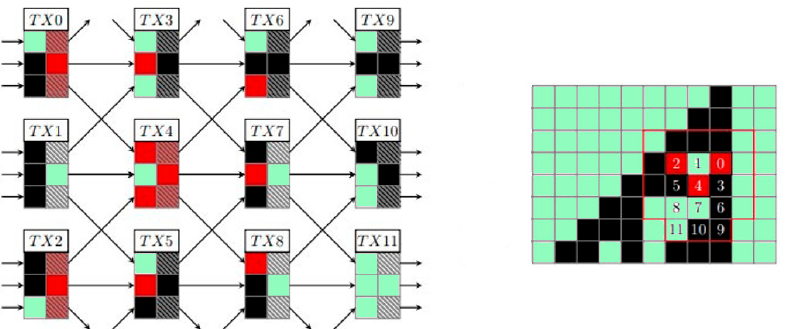
Figure 3. Evolution of a cellular automaton rule 110. Every non-boundary transaction spends three outputs, and generates three new ones with identical bit values. Hatching indicates “mid” flag being un-set. Numbers in the cells on the right pane correspond to the transaction numbers on the left [23]. Harris and Waggoner propose to reduce the current centralization of AI with a framework to post and train models on Ethereum blockchain [24]. Their experiment used a single layer perceptron model on reviews of movies. Ethereum’s high gas costs limited their experiment to small inputs such as